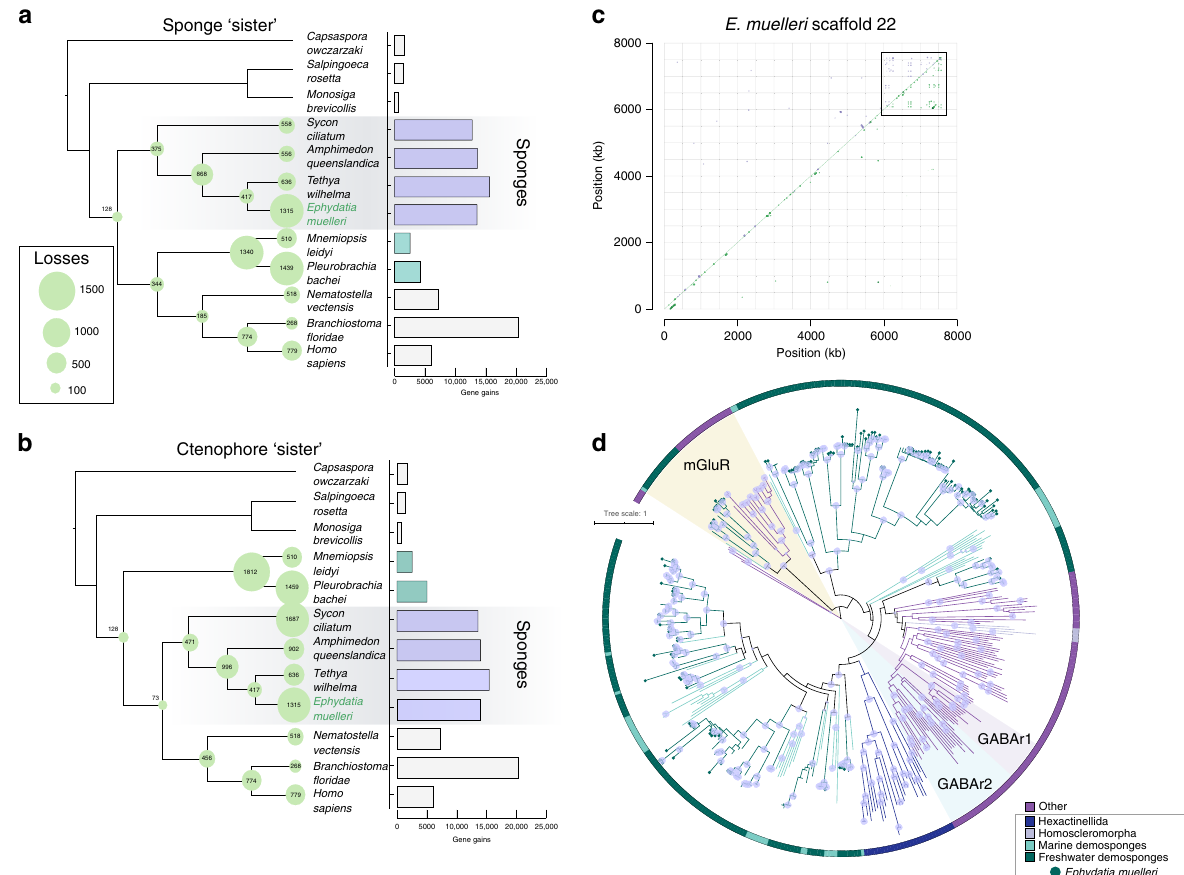
Fig. 4 Gene gain and loss and its role in freshwater evolution. Gene gains (histogram at right) and losses (numbers in circles at nodes) across sponge and metazoan phylogeny, as assessed using a selection of choano fl agellate, sponge, ctenophore, and eumetazoan species with full genome sequence available, assuming sponges ( a ) or ctenophores ( b ) are sister to other metazoans, as shown on representative cladograms. Note that the large number of apparent gains in Branchiostoma fl oridae is largely due to incompletely curated records in that resource. Sponges show a uniformly high rate of gene gain relative to other metazoans. E. muelleri shows considerable gene losses, but this is likely less acute in reality due to incomplete gene models. c Example of a highly duplicated gene in E. muelleri , the m GABA receptor. Here we show the incidence of this gene, as a segmental duplicate dotplot, on scaffold 22. Same strand (forward) matches are represented in green, and reverse strand matches in purple. Boxed is the cluster of extremely high duplication levels of this gene. d Phylogeny of mGluR and mGABAR genes, rooted with Capsaspora owczarzaki sequences. Phylogeny generated in IQTREE v1.6.9 under the WAG + F + R9 model, based on a 1364-position (appx 45% gaps) amino acid alignment generated in MAFFT v7.313 (with -linsi options). Tree visualised in iTOL, with mGluR , vertebrate GABAR1 and GABAR2 genes shaded. Dots on nodes represent nodes with 100% bootstrap support. Colour of branches and outer circle indicates origin of sequences, with Ephydatia muelleri and other species coloured as seen in Legend, bottom right. Note the extreme level of duplication of these genes seen in sponges in general, and in freshwater lineages in particular. Source data are provided as a Source Data fi